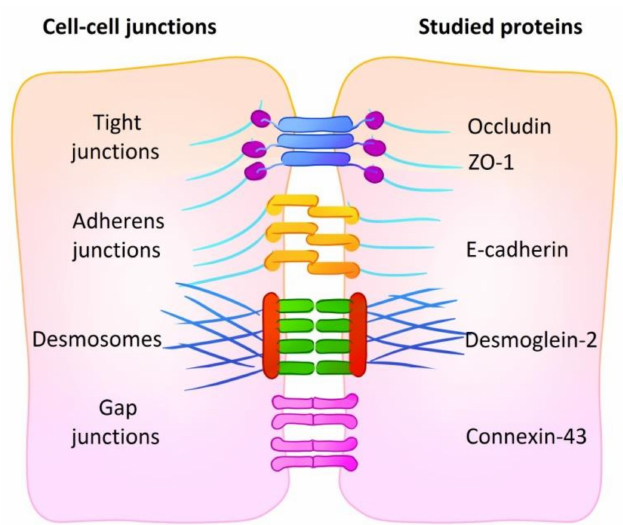
Figure 2. A summary of cell–cell junctions with representative proteins. The abundance of five proteins of four types of cell junctions was analyzed: E-cadherin (adherens junctions), desmoglein-2 (desmosomes), connexin-43 (gap junctions) and occludin and ZO-1 (tight junctions). E-cadherin . According to the obtained data, the expression of E-cadherin was extremely low in both SKOV-3 and SKOV-3.ip cells; the values of RF do not exceed 1.5–2. Cultivation in 3D models